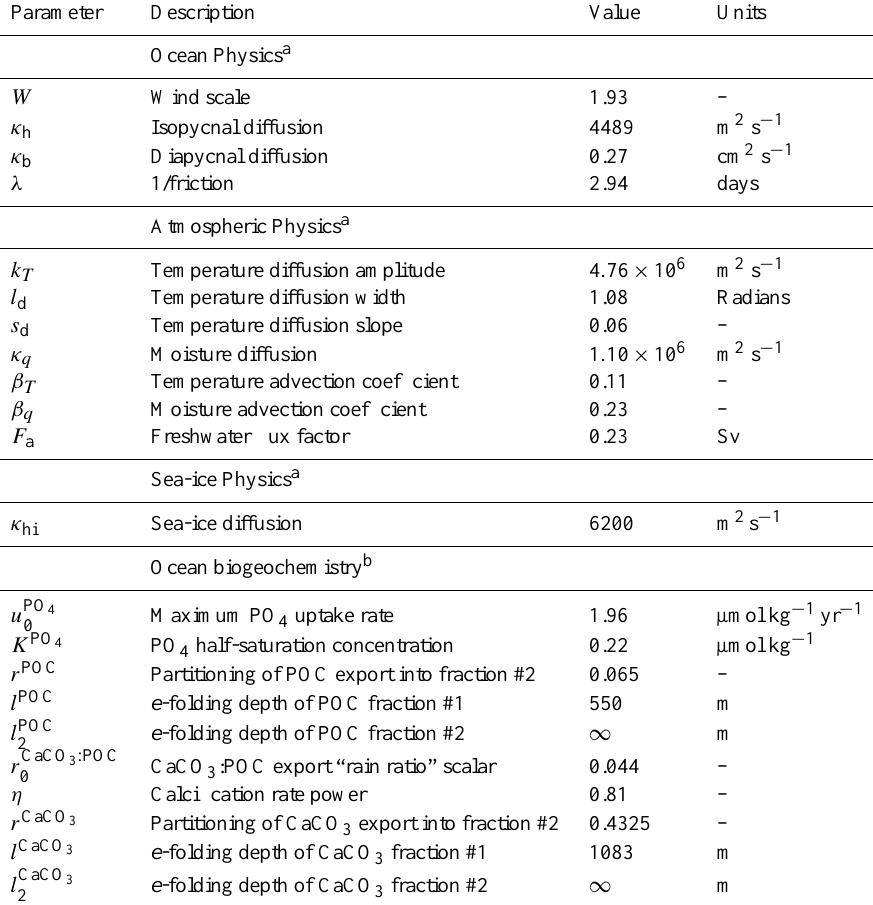
Table 1. Default physics and biogeochemistry parameters for GENIE-1 as used in this paper (Cao et al., 2009).